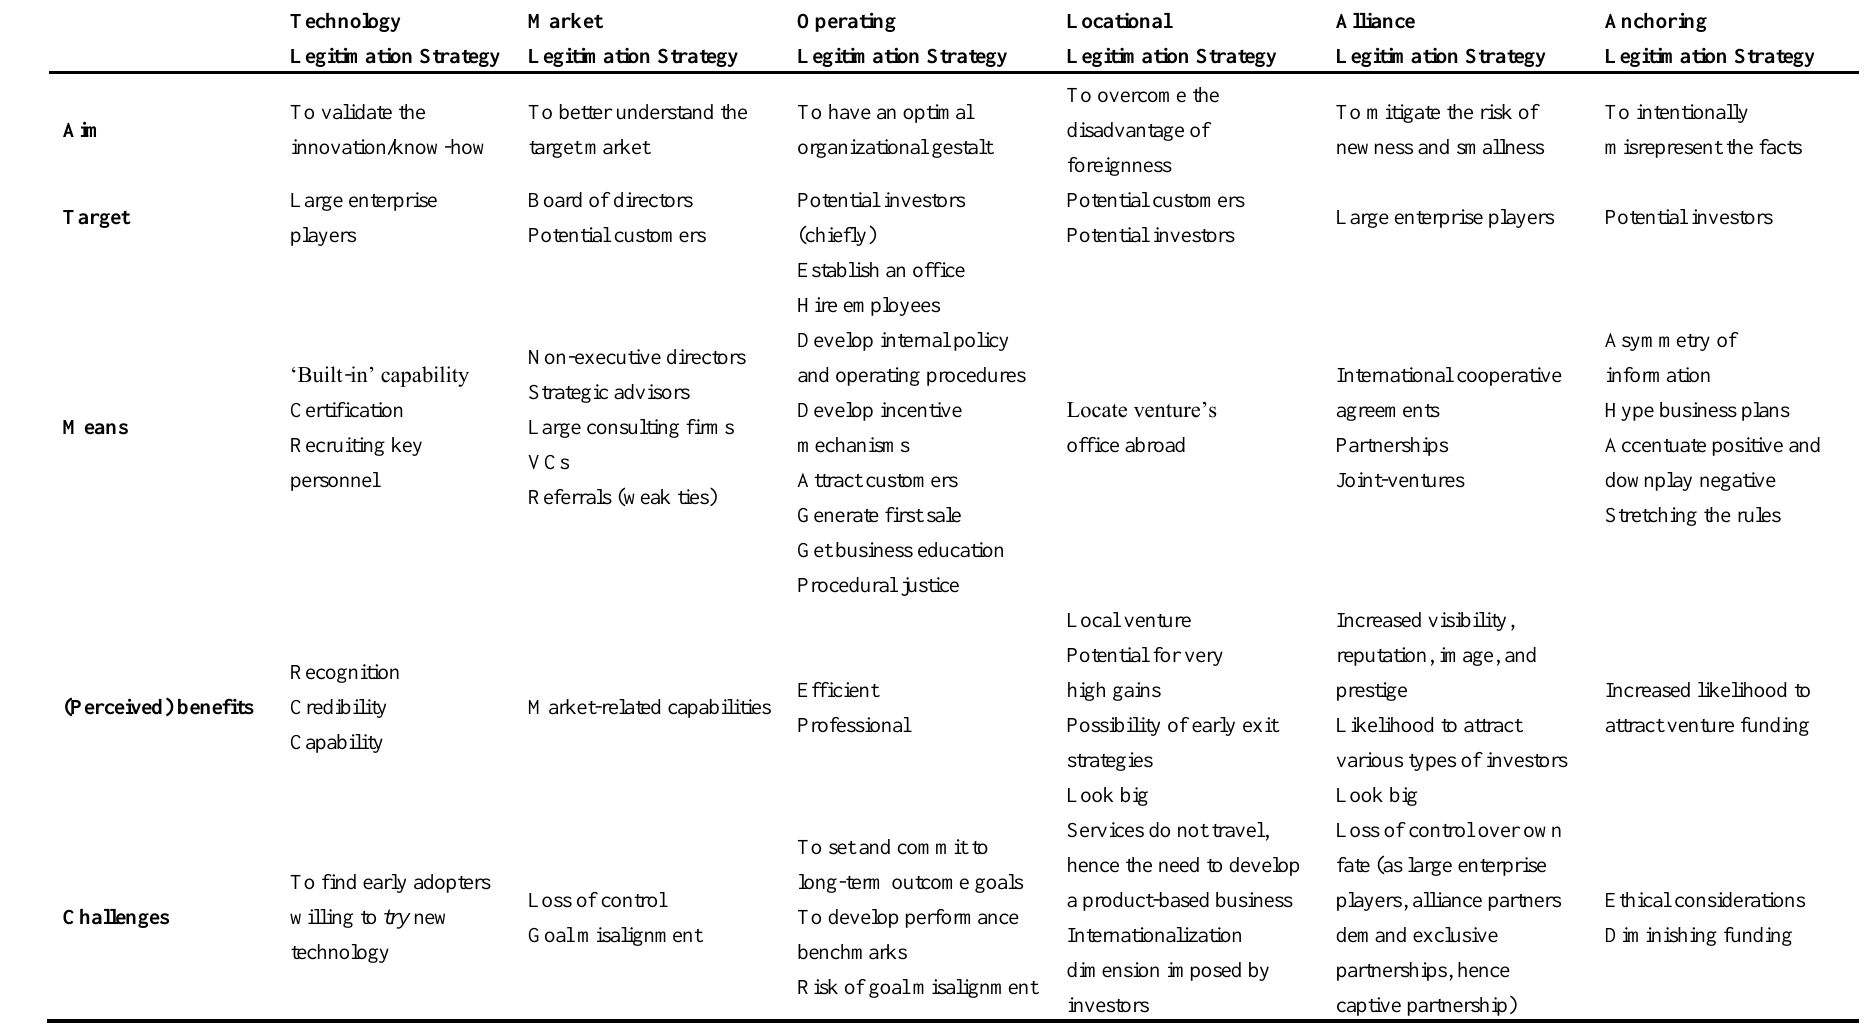
Table 3. International new venture